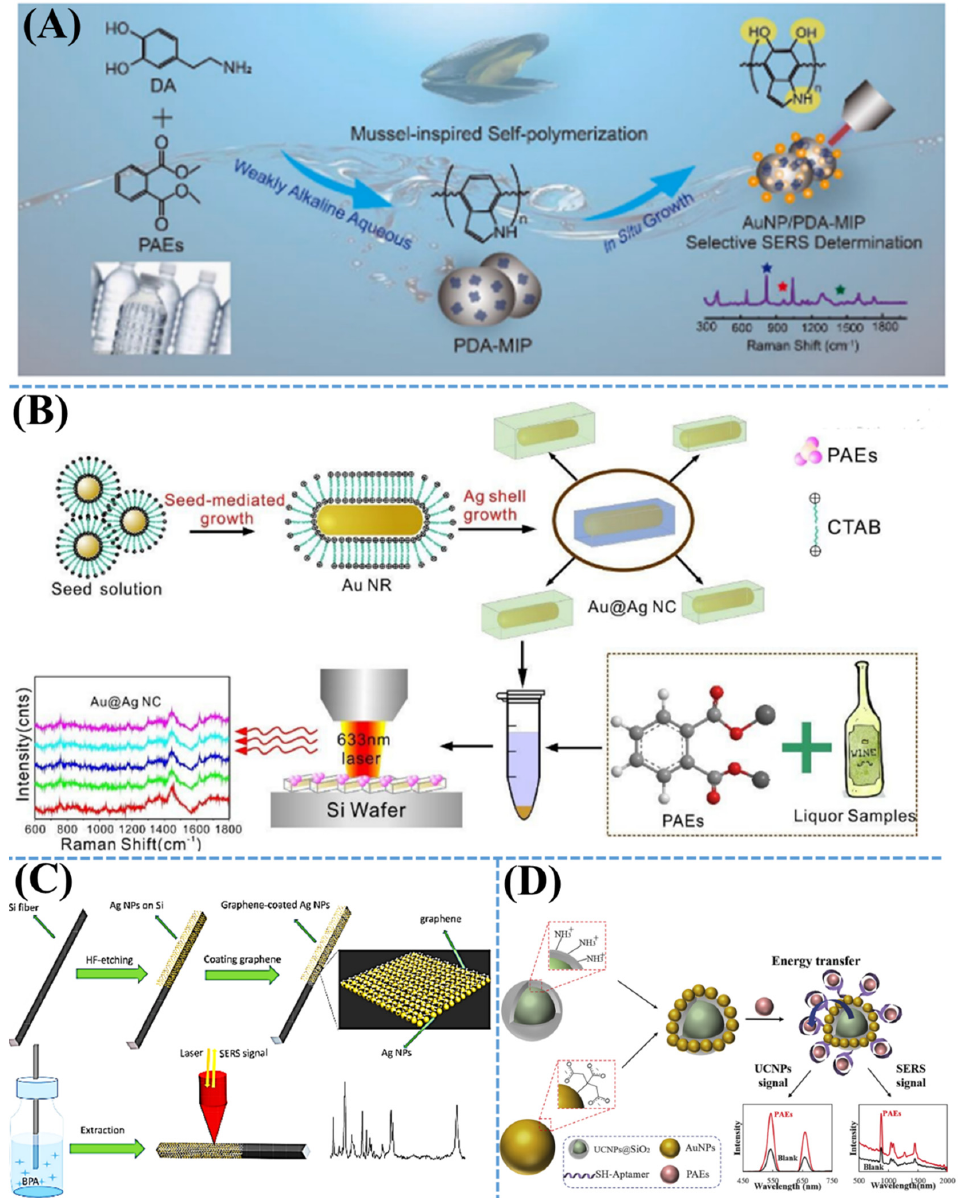
Figure 4. ( A ) Schematic illustration of SERS substrate for selective detection of PAEs using AuNP-coated PDA-MIP template. Adapted from [74]. ( B ) Diagram of SERS sensitive detection of PAEs using bimetallic plasmonic Au@Ag nanocuboids. Adapted from [73]. ( C ) Demonstration of SERS-active solid phase microextraction fiber detection of BPA. Adapted from [72]. ( D ) Diagram of SERS and fluorescence detection of PAEs using aptamer-assisted AuNP hybrid nanostructures. Adapted from [71].